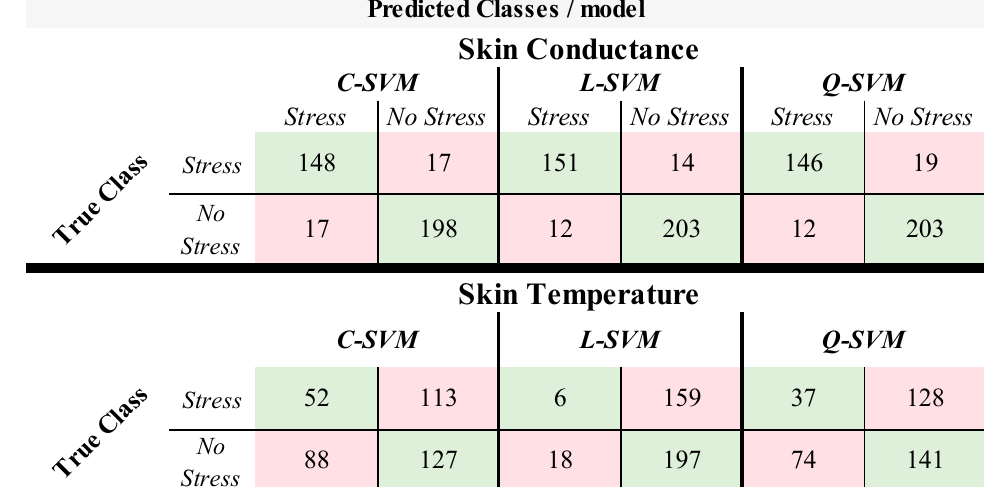
Figure 4. Confusion matrix for each signal per classifier. Figure shows the correctly classified (green rectangles) cases per class. Overall, the training dataset consisted of 380 cases; 165 in the class stress and 215 in the class nonstress. Green parts show the correctly classified cases for each classifier.